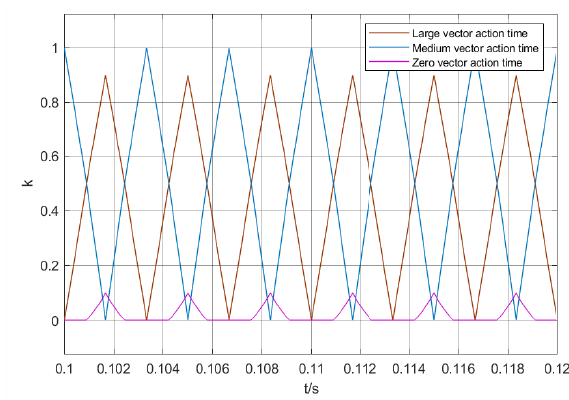
Figure 9. Action time of each vector when m = 0.9.